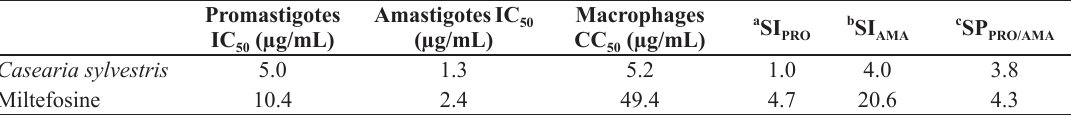
Effect of Casearia cf. sylvestris extract on Leishmania braziliensis , specificity and selectivity